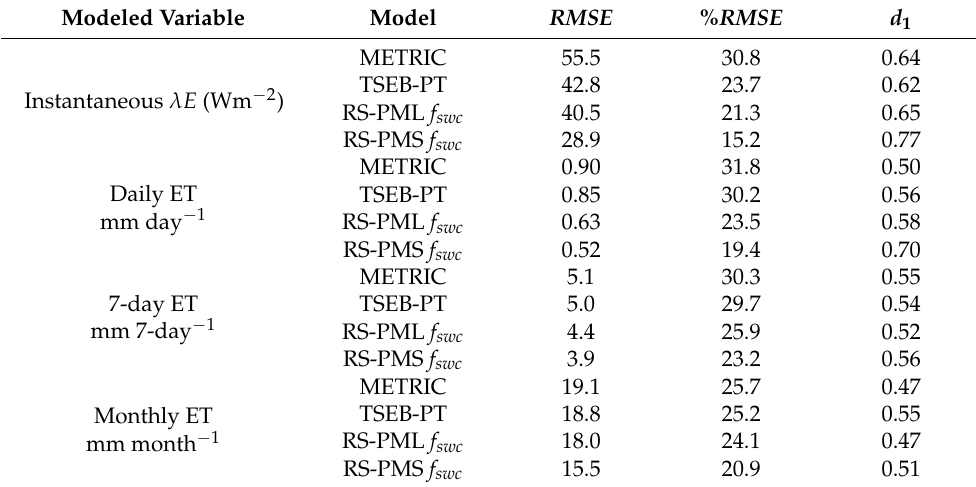
Table 5. Model comparison of estimations of evapotranspiration at different temporal scales.